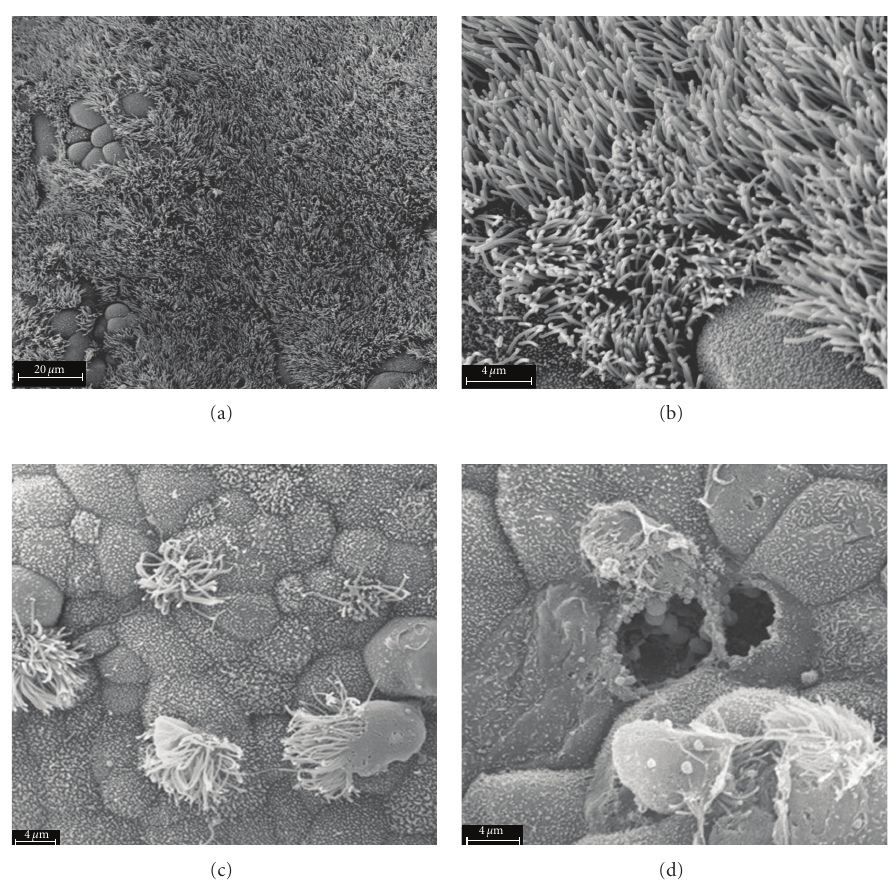
Figure 1: The e ff ects of C. trachomatis infection on human fallopian tubal morphology. Human fallopian tubes in organ culture were left uninfected (a and b) or were infected with C. trachomatis serovar D (c and d). Ultrastructural analysis of the intratubal architecture uses scanning electron microscopy. Uninfected tubes are densely ciliated and contain intact secretory cells. The mucosal surface of C. trachomatis - infected tubes show remarkable deciliation and cellular disruption ([9], and reproduced with